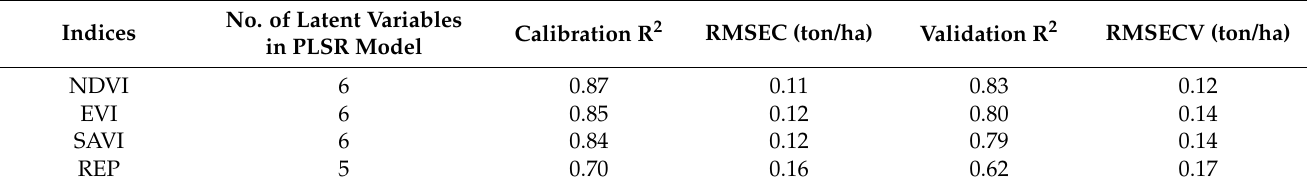
Table 3. Results of the PLSR applied to time series vegetation indices (NDVI, SAVI, EVI, and REP). Number of latent variables